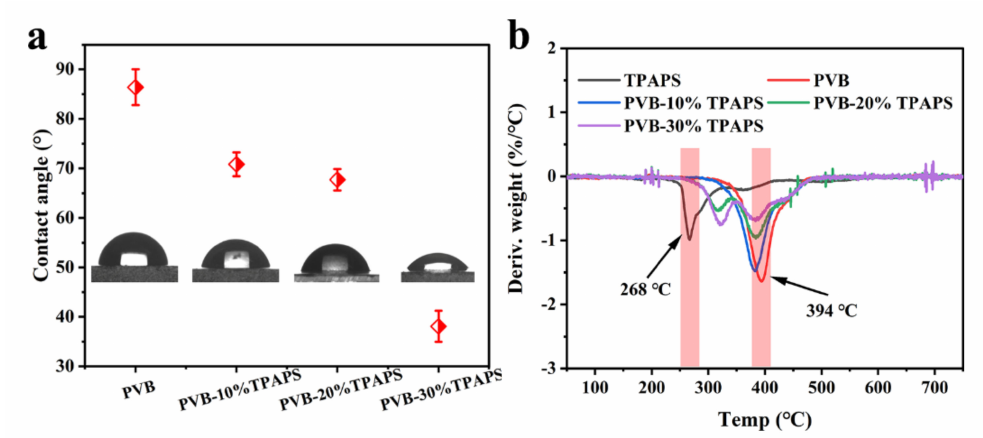
Figure 2. The surface wettability and thermal stability properties of PVB-X% TPAPS. ( a ) Water-droplet contact angles of the coatings; insets are corresponding images. ( b ) The derivative thermogravimetric (DTG) curves of the